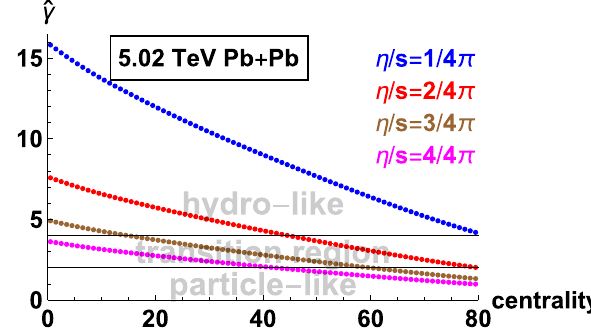
Fig. 6 The centrality dependence of ˆ γ , calculated from Eq. (32) for different values of η/ s . Horizontal lines denote the values ˆ γ = 2 below which the kinetic transport evolution is far from fluid dynamics and ˆ γ = 4 above which the system evolves fluid-like